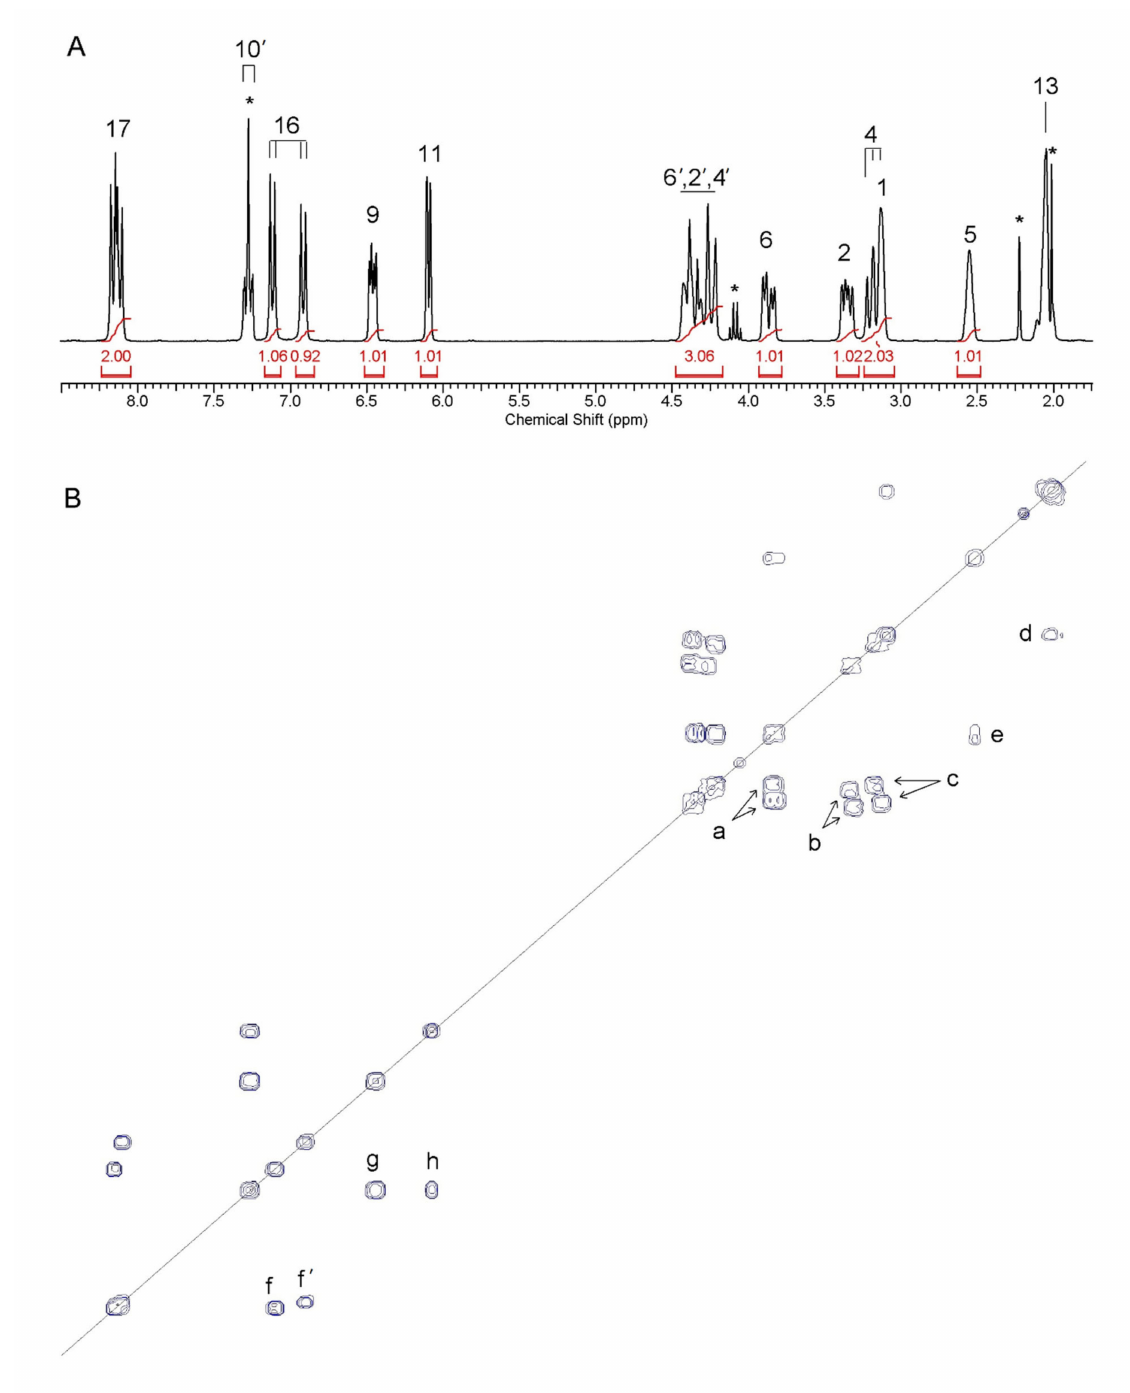
Figure 2. The 1 H-NMR of cytisine- N -( p -nitrophenylcarbonate) ( CNPC ) ( A ) and COSY ( B ) spectra in CDCl 3 : The impurities and residual CHCl 3 resonances are labeled with asterisks. Relevant cross peaks in the COSY spectrum are labeled with letters. For atom numbering in CNPC , see Scheme